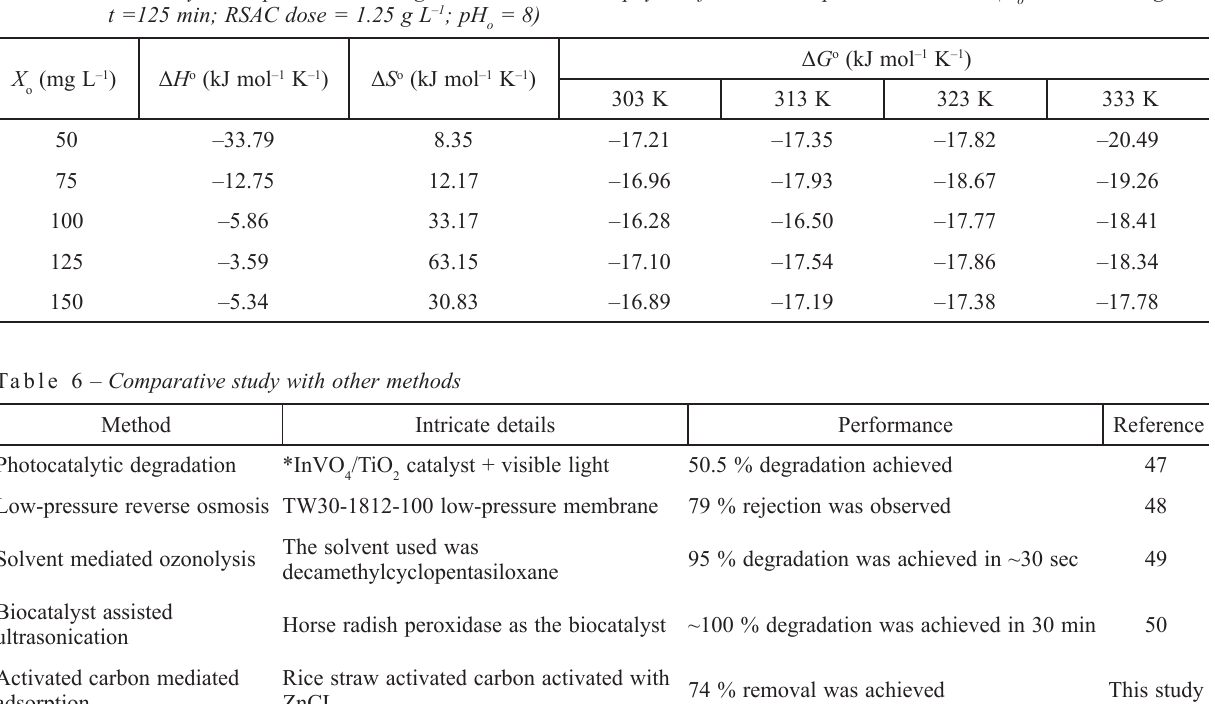
= 50–150 mg L –1 ; o